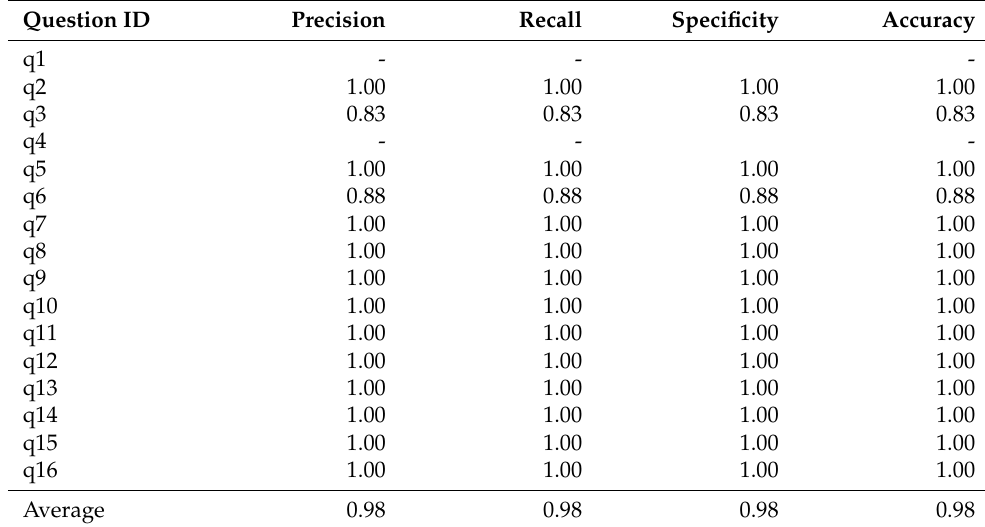
Table 3. Experimental results of extracting fact type in dataset_university1.